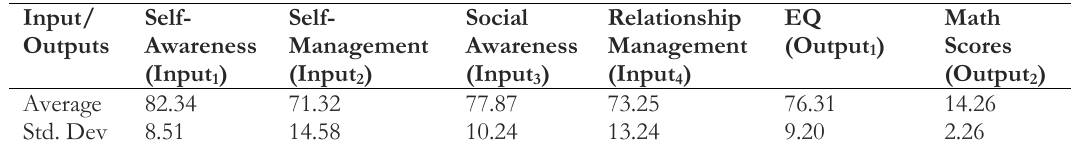
Table 1. Statistical description of data